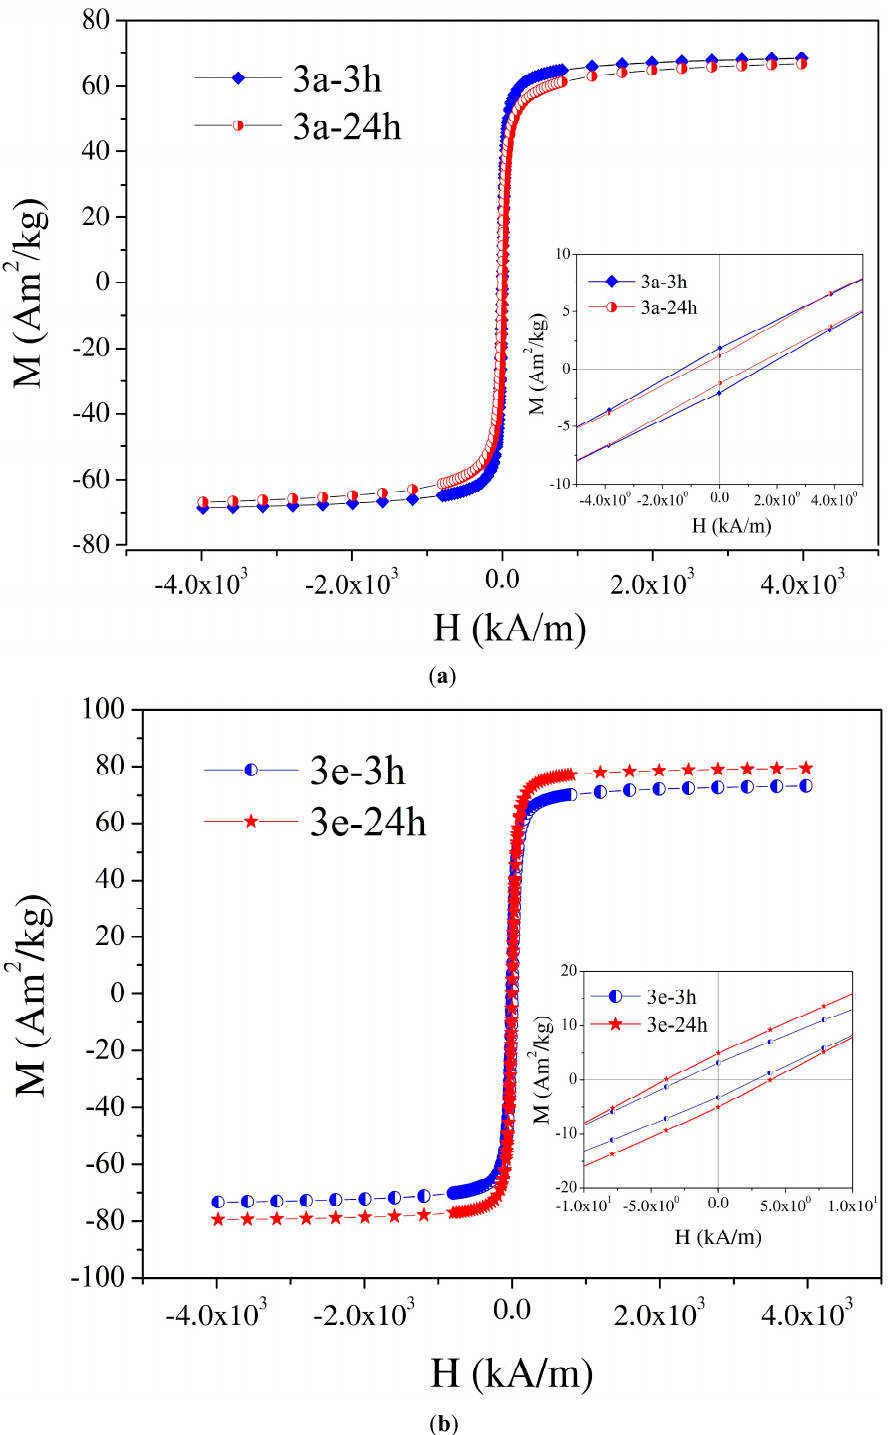
Figure 2. Magnetization versus applied magnetic field of magnetic nanoparticles (MNPs) at room temperature: ( a ) 3a -3 h, 3a -24 h; ( b ) 3e -3 h, 3e -24